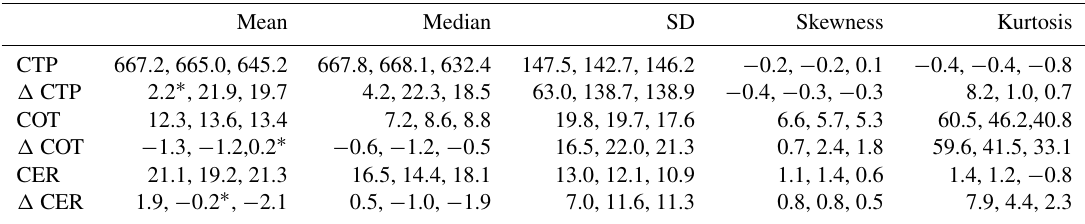
Table 6. Statistics of CTP, COT, and CER retrieval values for study area NA2 and AVHRR (first value in each cell), MODIS (second value), and AATSR (third value). (cid:49) values are given for AVHRR minus MODIS (first value in each cell), AVHRR minus AATSR (second value), and MODIS minus AATSR (third